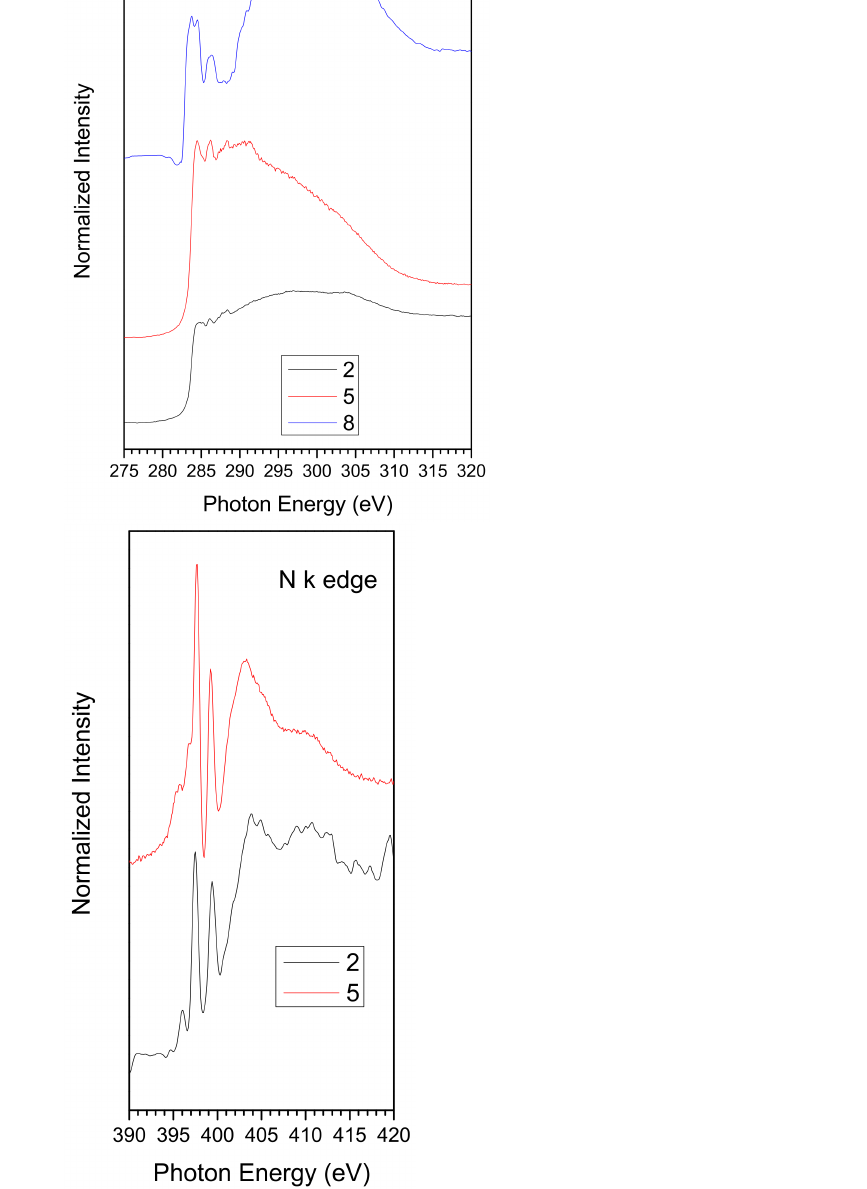
Figure 4. C K edge NEXAFS spectra of samples 2 , 5 , and 8 ( top ) and N K edge ( bottom ) NEXAFS spectra of samples 2 and 5